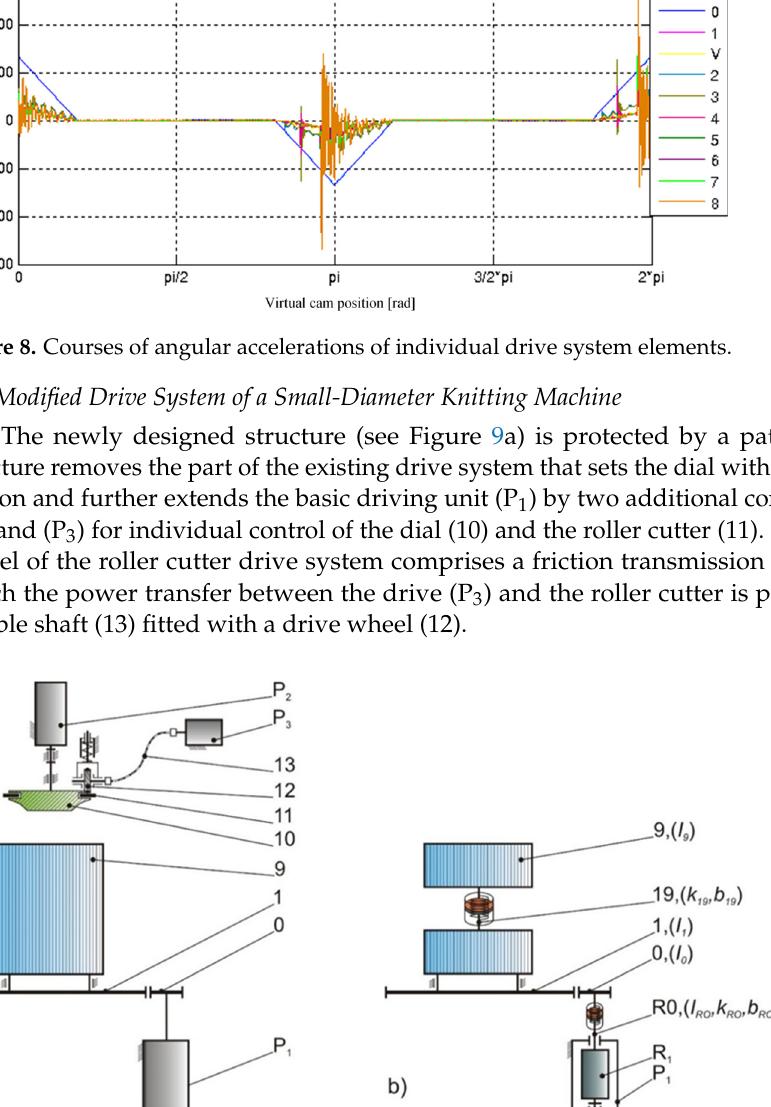
Figure 7. Courses of angular velocities of individual drive system elements.